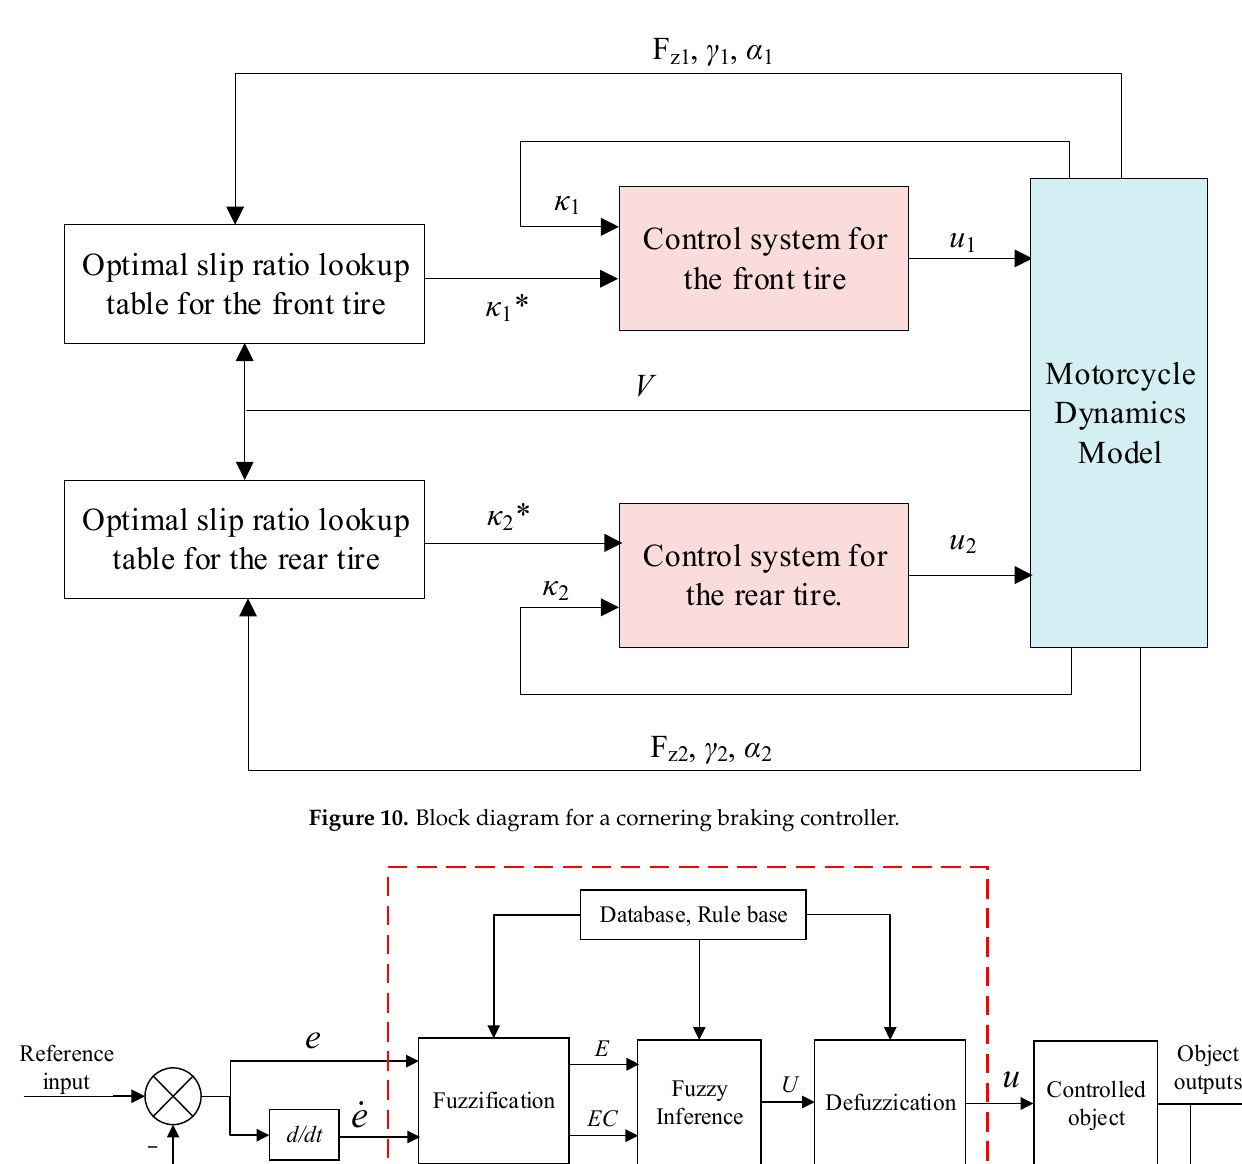
Figure 11. Principle of fuzzy logic control.